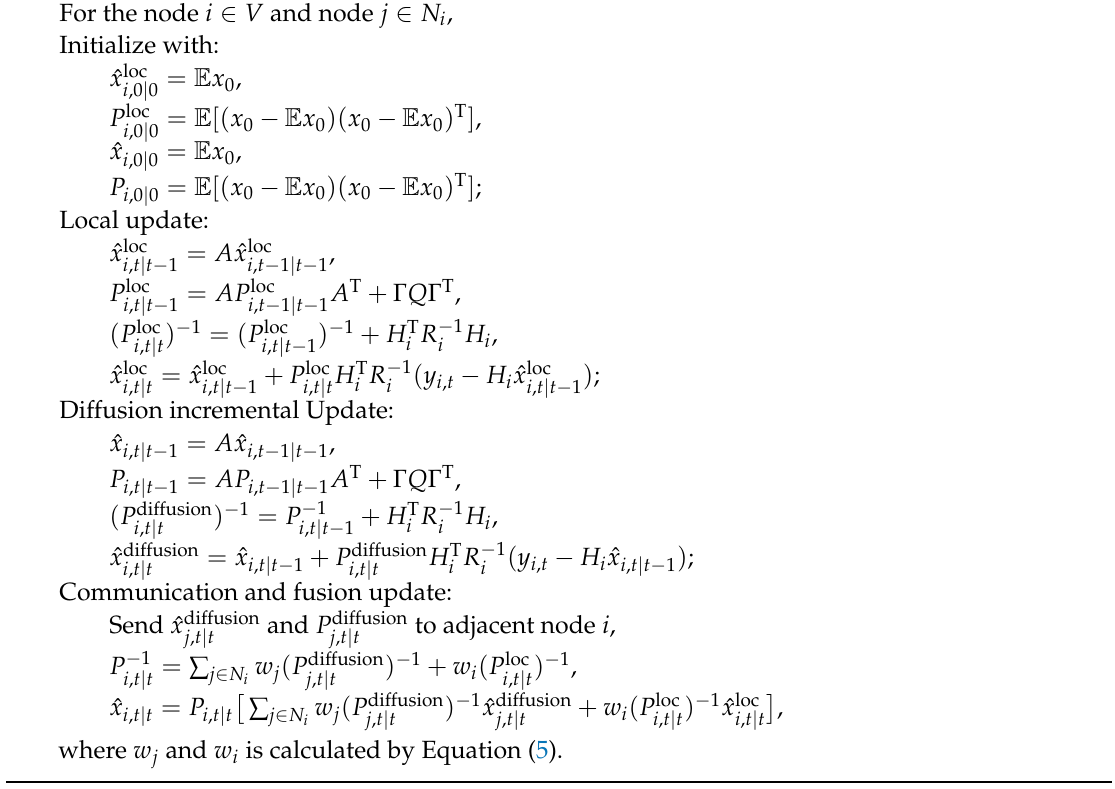
Algorithm 4: A diffusion distributed Kalman filter separating diffusion